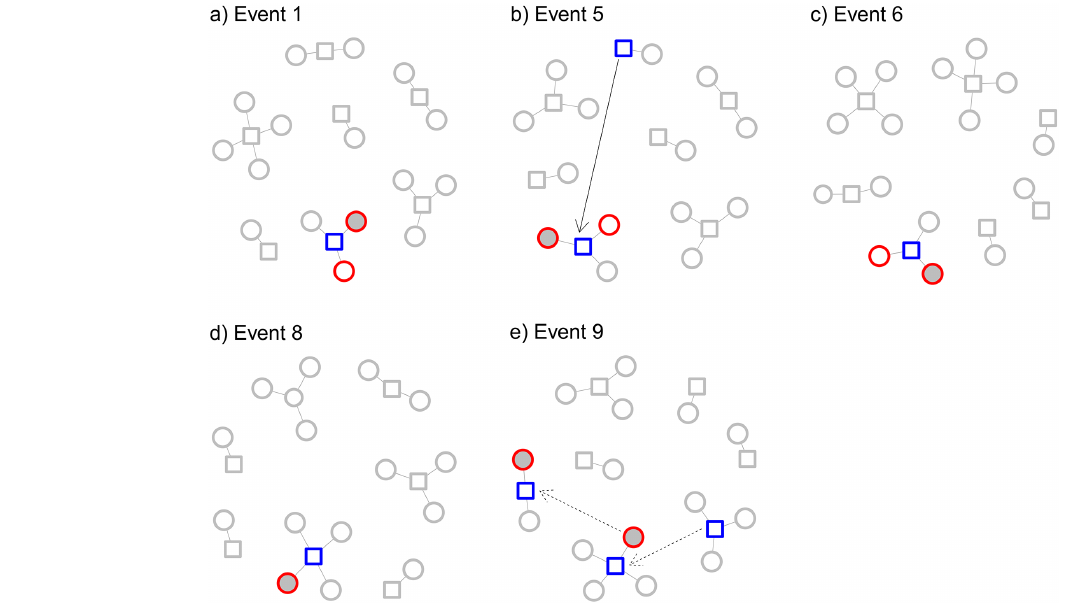
Figure 1. Five schematics (a–e) of the movement of meat between and within one male units. Node shape denotes sex (females =(cid:13) , males = (cid:3) ), colour indicates meat consumption (non-meat eaters are denoted by grey, male meat eaters are denoted by blue, female meat eaters are denoted by red). The arrows show the movement of meat from one unit to another, with the solid arrow showing the theft of a carcass; while the dashed arrows show the acquisition of meat by males through scavenging. Filled circles indicate females who also obtained meat via scavenging. Note that unit composition varied between the five events and that the secondary males have been excluded as no transfers occurred between primary and secondary males during the study period.